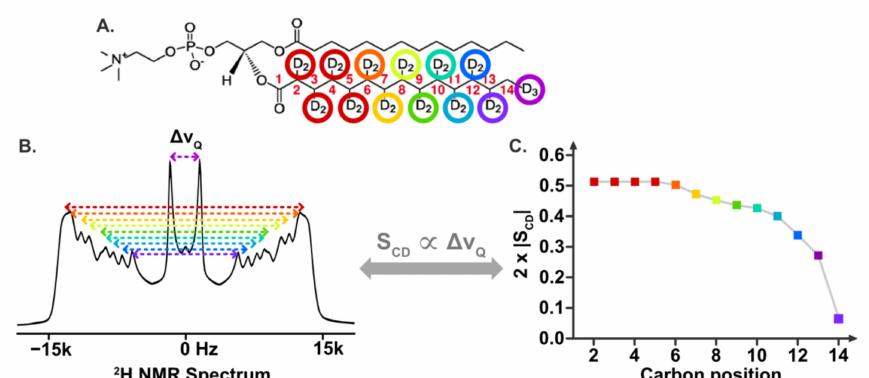
Figure 3. Illustration of how a 2 H NMR spectrum can be used to obtain the order profile of a lipid membrane. (Panel A ) shows a 2 H-labeled molecule of dimyristoyl-phosphatidyl-choline, namely 2 H 27 -DMPC, where all carbons from the sn2 chain are perdeuterated. To ease the interpretation of the figure by the reader, each deuterated methyl leading to a di ff erent quadrupolar splitting ( ∆ ν Q ) is tagged by a di ff erent color. (Panel B ) shows a 2 H NMR spectrum where all the ∆ ν Q that are visible are labeled using the color that corresponds to the deuterated carbon position. (Panel C ) shows the order profile where the S CD value for each position is calculated directly from each ∆ ν Q value panel B, as S CD and ∆ ν Q are